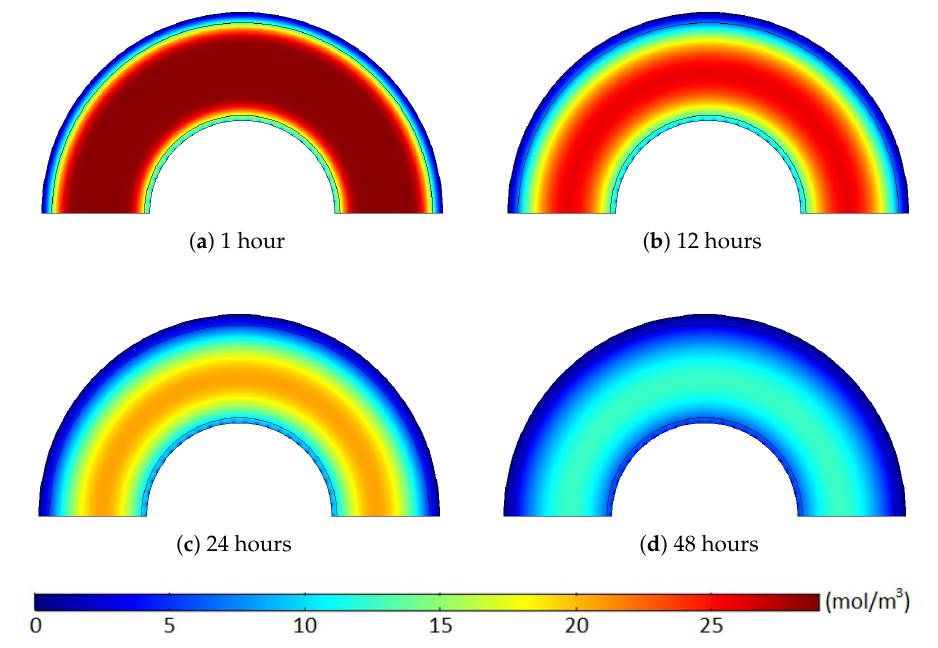
Figure 11. Methane concentration (mol/m 3 ) over time with the internal holes where the target degassing chamber temperature is 343.15 K and C l = 1/90. ( a ) 1 hours, ( b ) 12 hours, ( c ) 24 hours, ( d ) 48